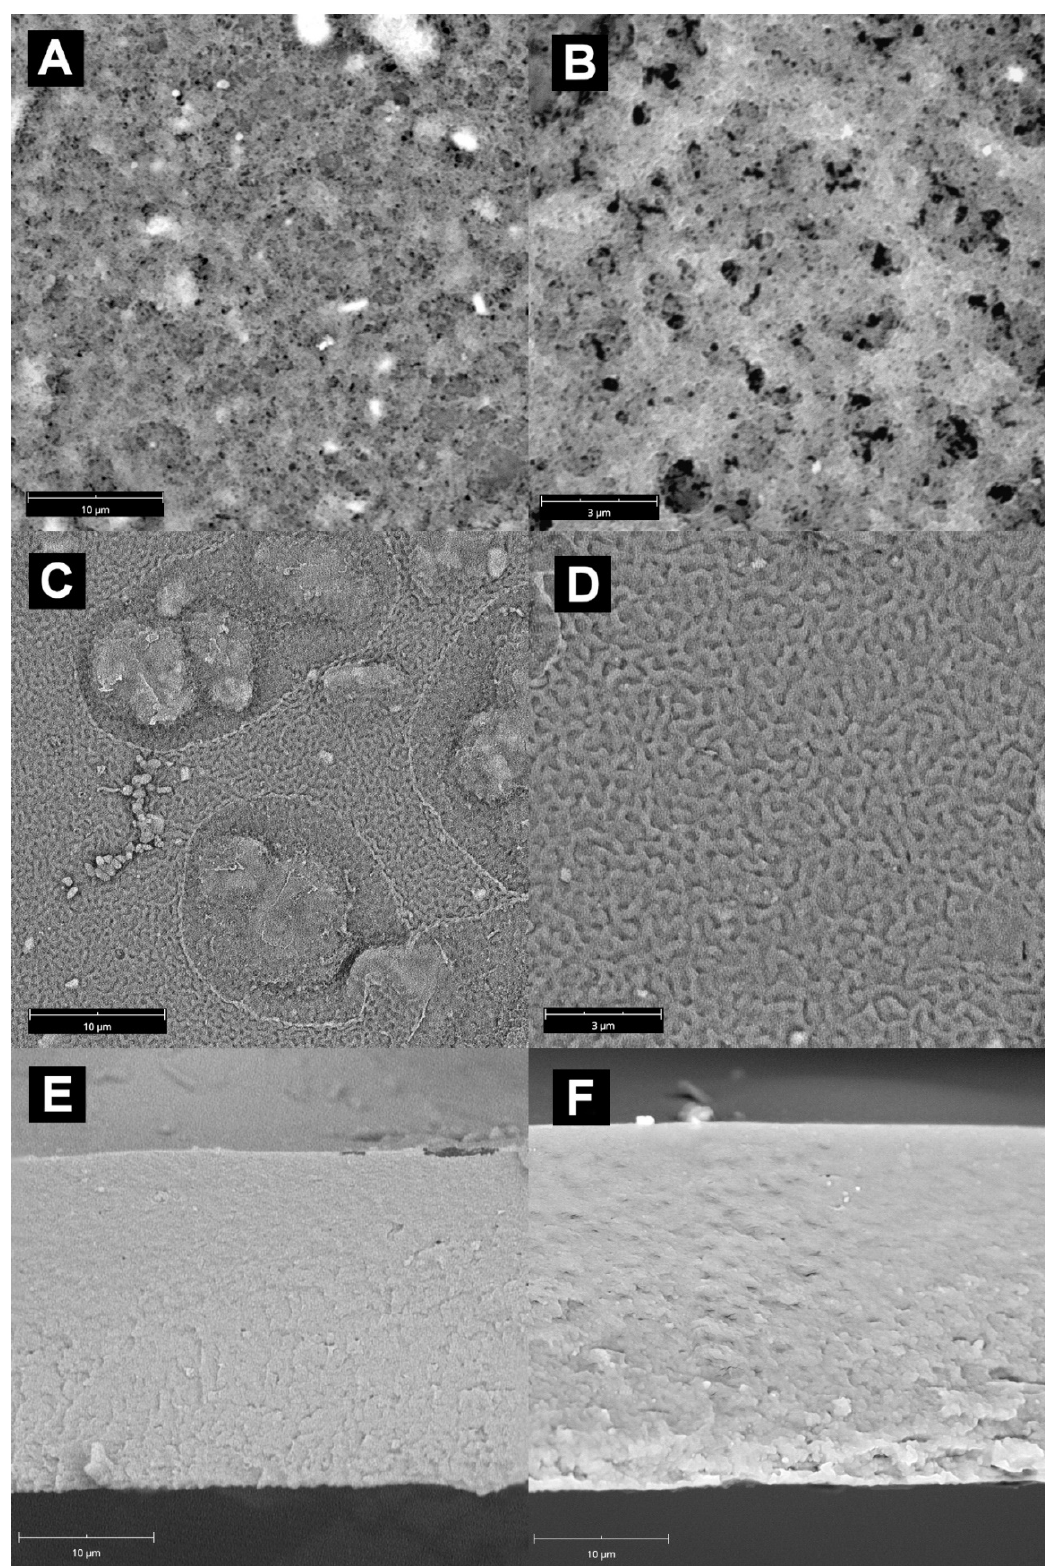
Figure 2. The SEM images of Alg–MnO 2 membranes: ( A , B )—membrane surface with 5 wt.% filler content, magnification 7 k and 20 k, respectively; ( C , D )—membrane surface with 15 wt.% filler content, magnification 7 k and 20 k, respectively; ( E , F )—cross-section of membrane with 5 wt.% and 15 wt.% filler content, respectively. Magnification 7 k.